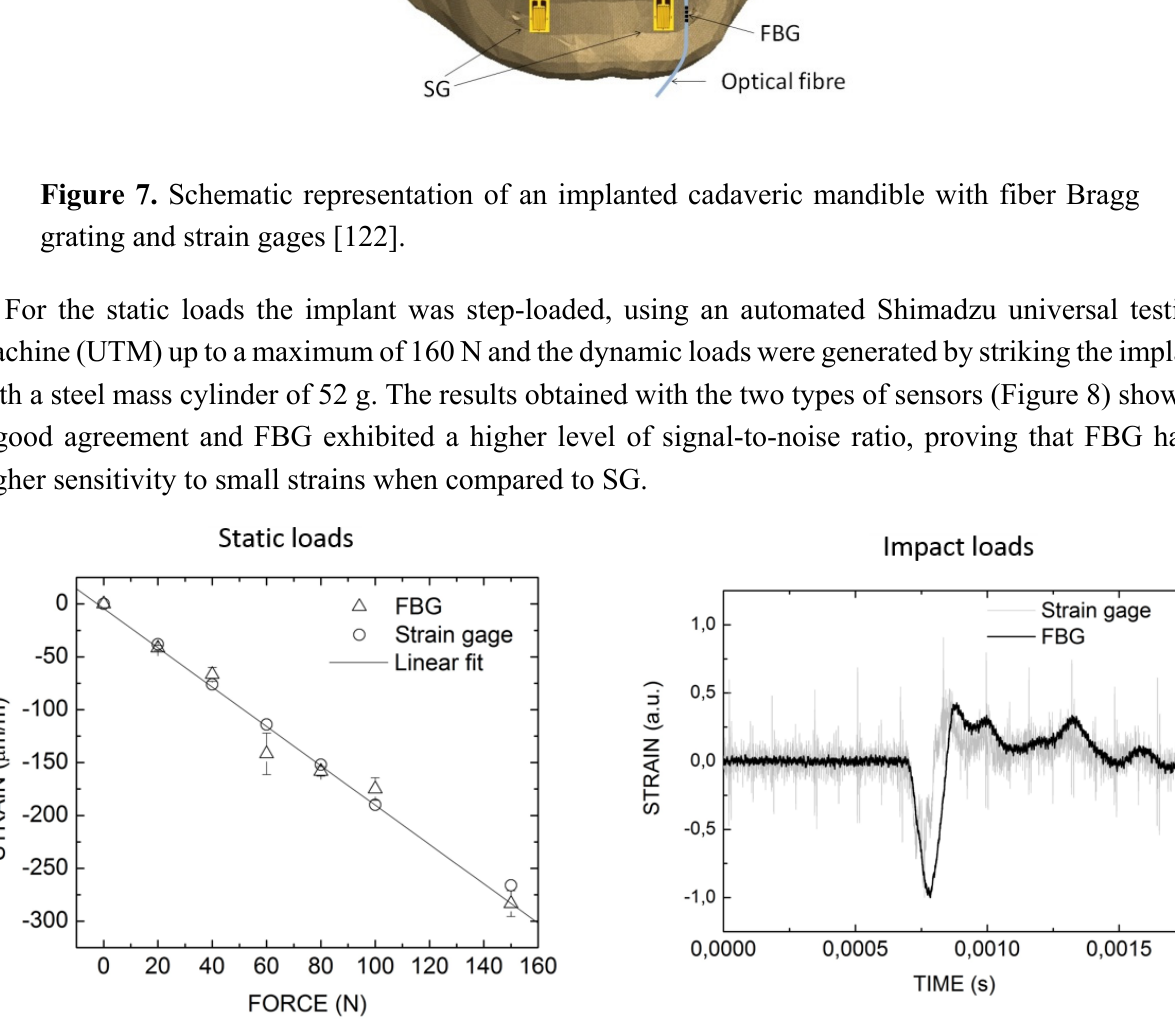
Figure 8. Comparison of results obtained with an implanted cadaveric mandible and measured with fiber Bragg grating and strain gages. Left: for static load; Right: and impact loads